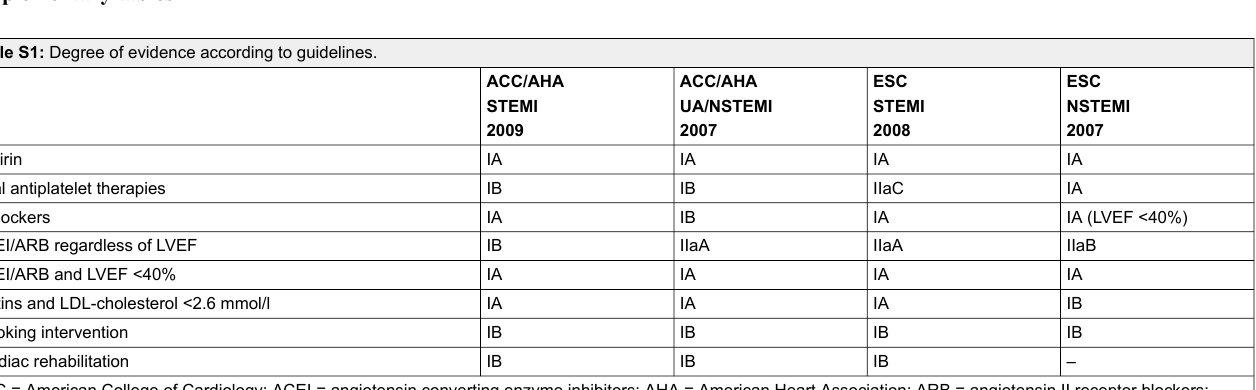
Table S1: Degree of evidence according to guidelines.